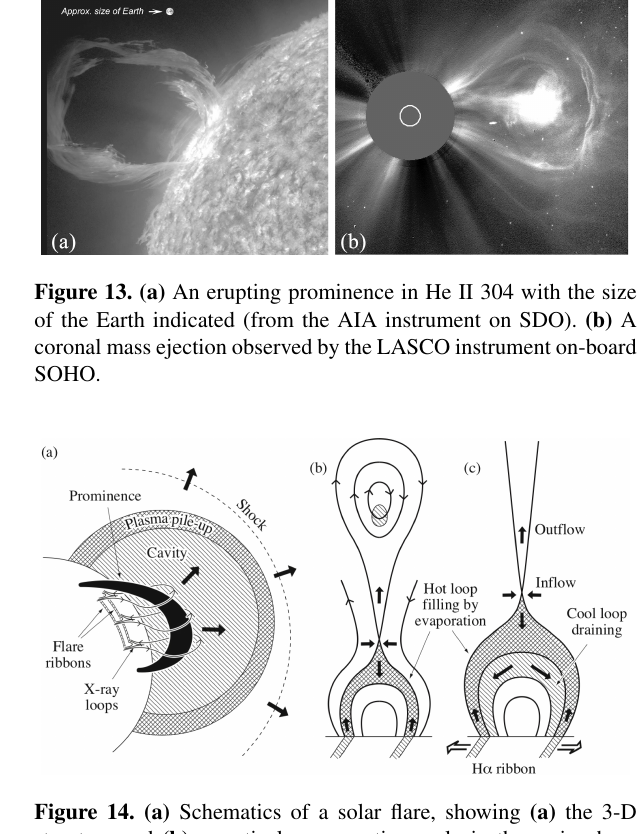
Figure 14. (a) Schematics of a solar flare, showing (a) the 3-D structure and (b) a vertical cross section early in the main phase and (c) later